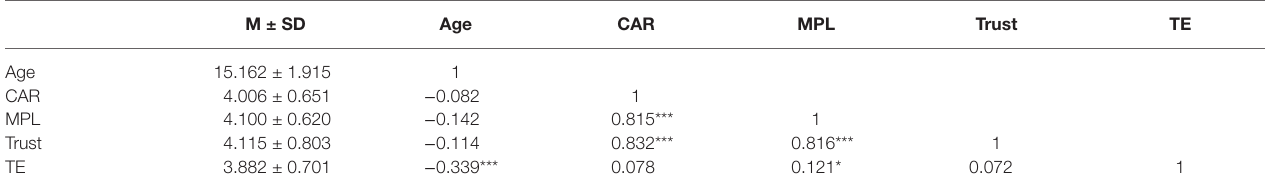
TABLE 1 | Variable descriptive